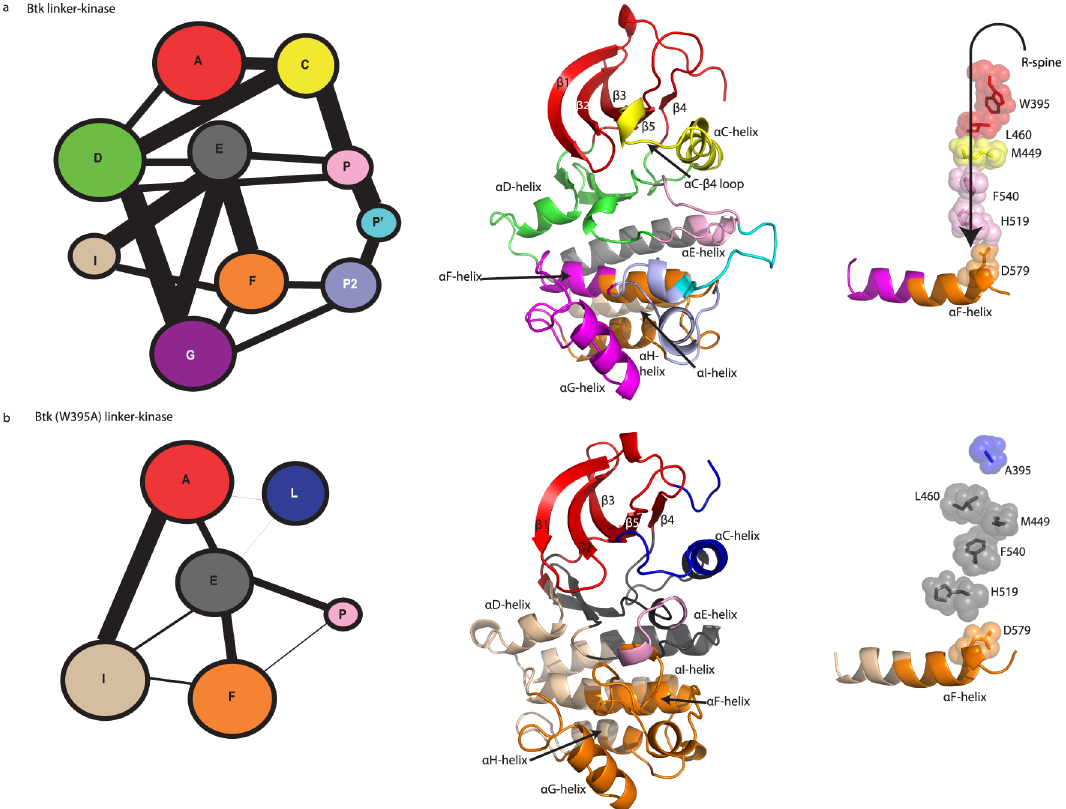
Fig 5. Community analysis. The community network in Btk linker-kinase (a) and Btk (W395A) linker-kinase (b) domains. (a,b left panel ) The area of the circle indicates the number of residues within each community and the weight of the lines connecting communities is proportional to the extent of correlation between communities. ( middle panel ) Communities of residues mapped onto the Btk linker-kinase domain structure for Btk linker-kinase (a) and Btk (W395) linker-kinase (b). ( right panel ) R-spine communities for the Btk linker-kinase simulation (a) and the Btk (W395A) linker-kinase simulation (b).